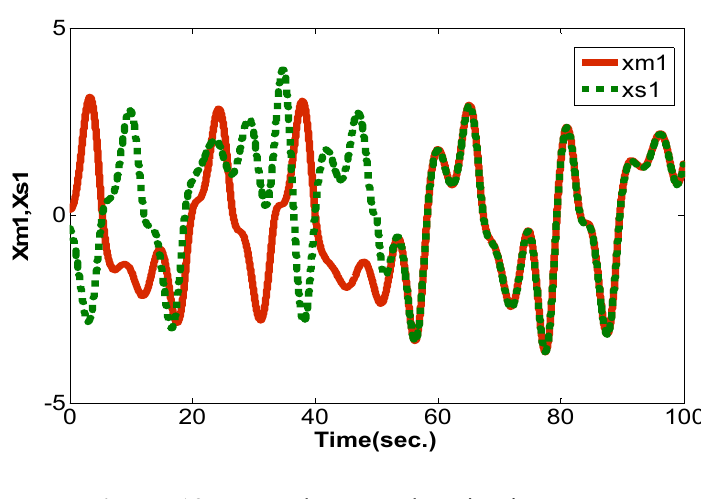
and x synchronization curve. m1 s1